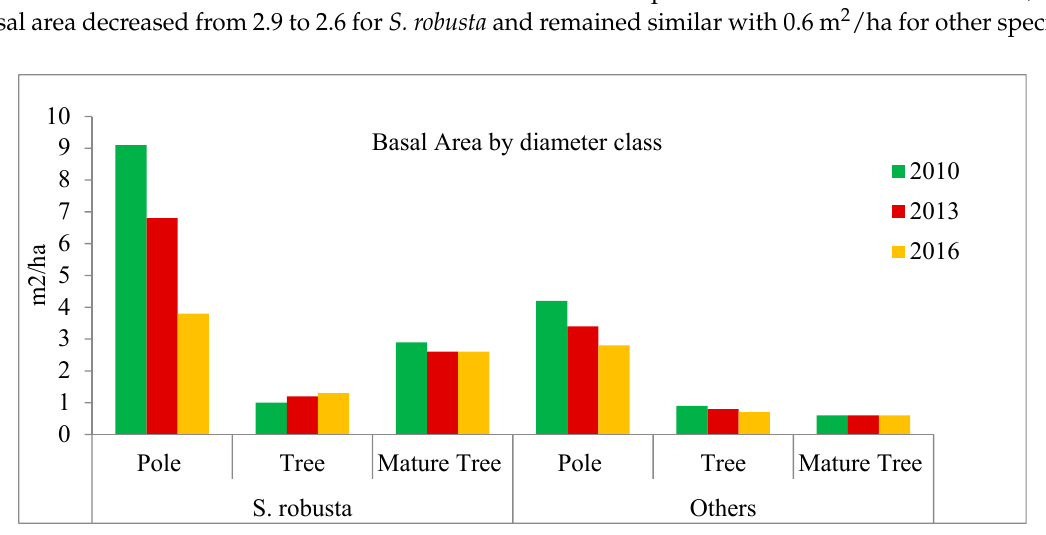
Figure 5. Basal area per ha by species types (m 2 /ha). Source: Inventory of 2010, 2013 and 2016.